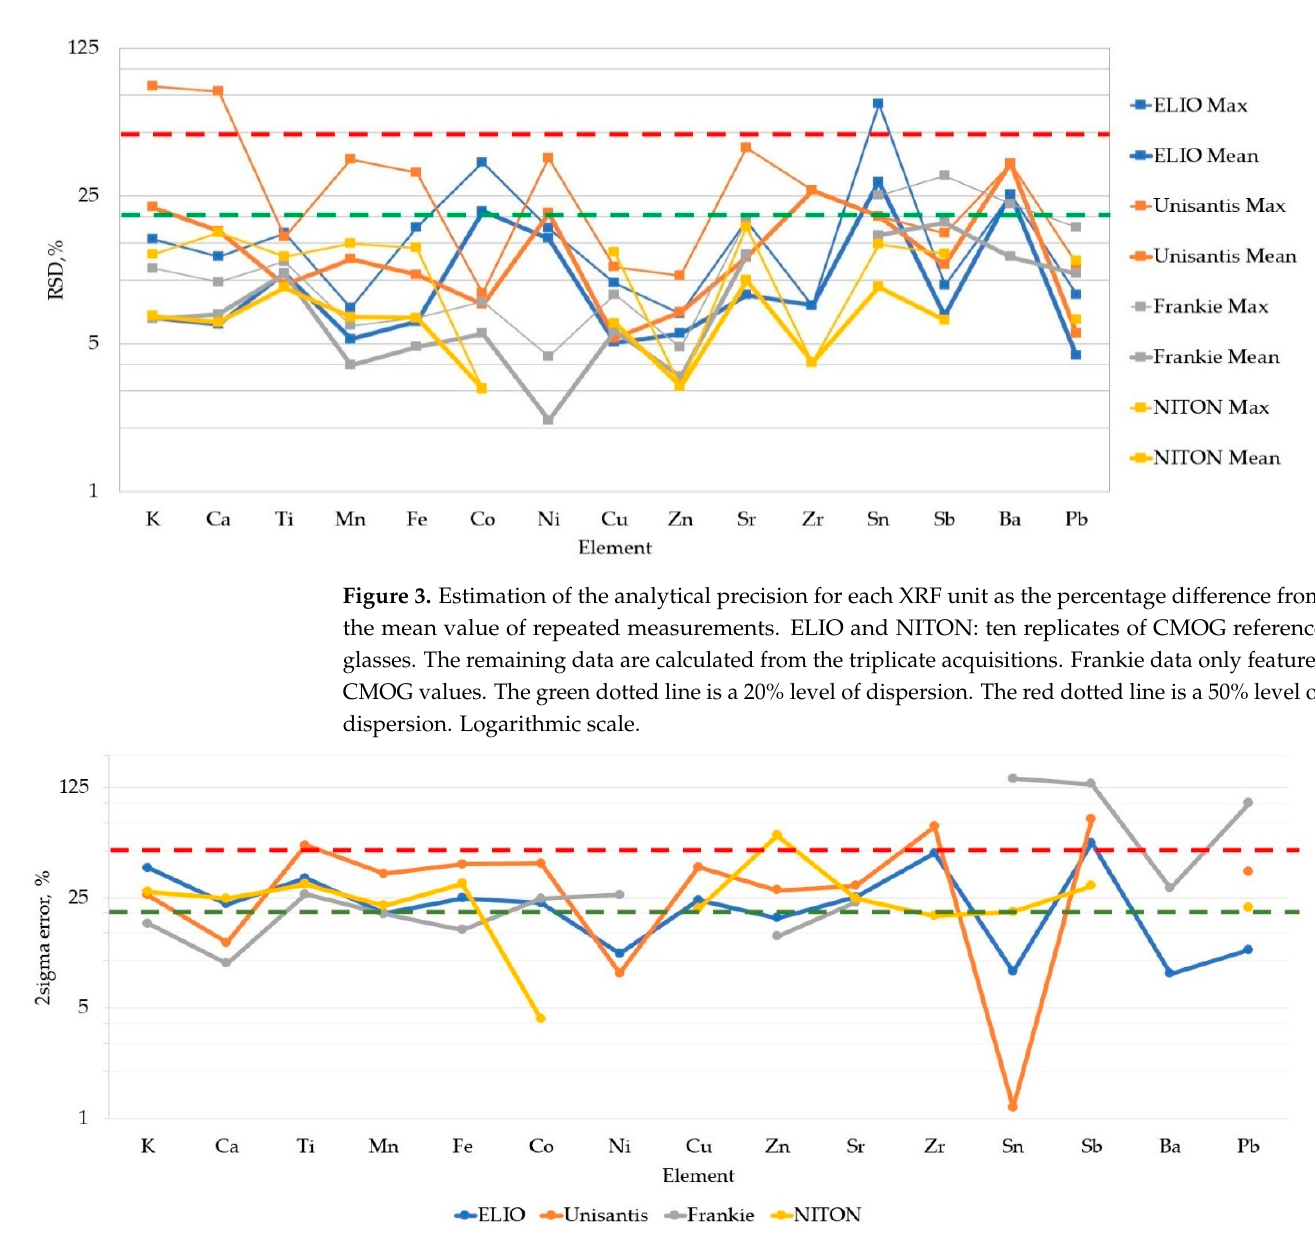
Figure 4. Accuracy assessment of the values of each XRF unit, calculated with the FP method. The green dotted line represents a 20% relative error (95% confidence). The red dotted line represents a 50% relative error (95% confidence).